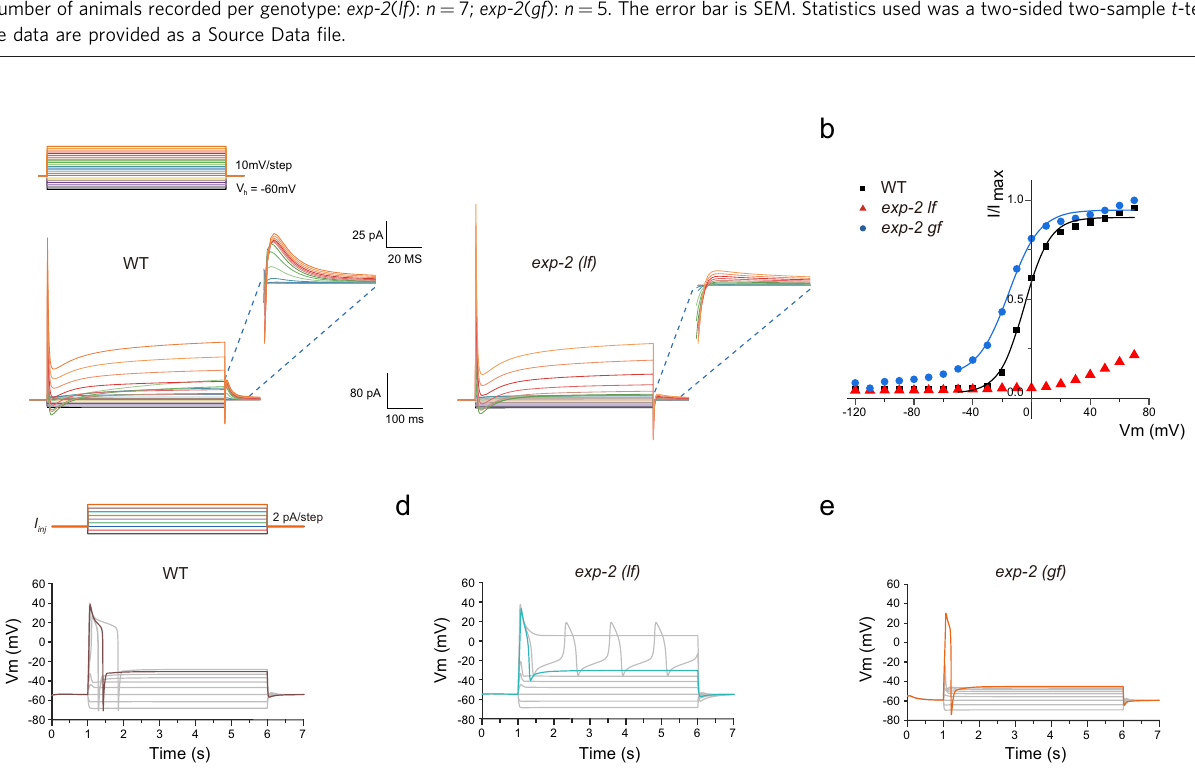
Fig. 4 Modeling of AVL action potentials. a Simulation of voltage-clamp of AVL in the wild type (left panel) and the exp-2 ( lf ) mutant (right panel). Top: voltage-clamp steps used in numerical simulation: holding potential is − 60 mV, each step is 500 ms long in 10 mV increment. Inserts: zoomed-in view of currents from 0 to ~60 ms after returning to holding potential from serial voltage-clamp steps. b Current-voltage (I – V) relationships of normalized simulated repolarization-activated currents for WT (black squares), exp-2 ( lf ) (red triangles), and exp-2 ( gf ) (blue circles). WT and exp-2 ( gf ) IV curves were fi tted with Boltzmann functions (color-matching curves). c Representative action potential modeling simulations for wild-type AVL. Top: current-injection steps used in numerical simulation: each step is 5 s long in 2 pA increment. d , e Representative action potential simulations for exp-2 ( lf ) and exp-2 ( gf ) mutants under the same series of current-injection steps to wild-type